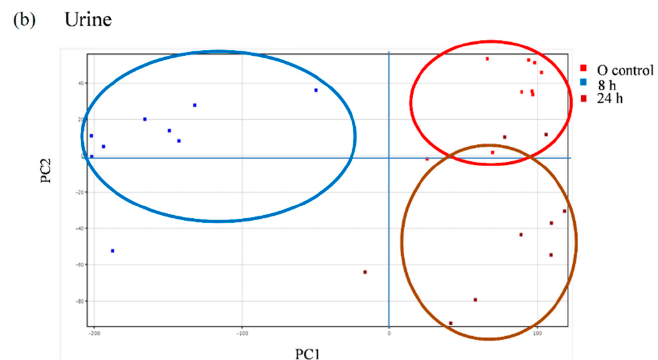
Figure 6. Principal component analysis (PCA) scores plot of the plasma ( a ) and urine ( b ) samples of nine volunteers analyzed at baseline (control) and at different time-points after the intake of the Fraxinus angustifolia Vahl extract.